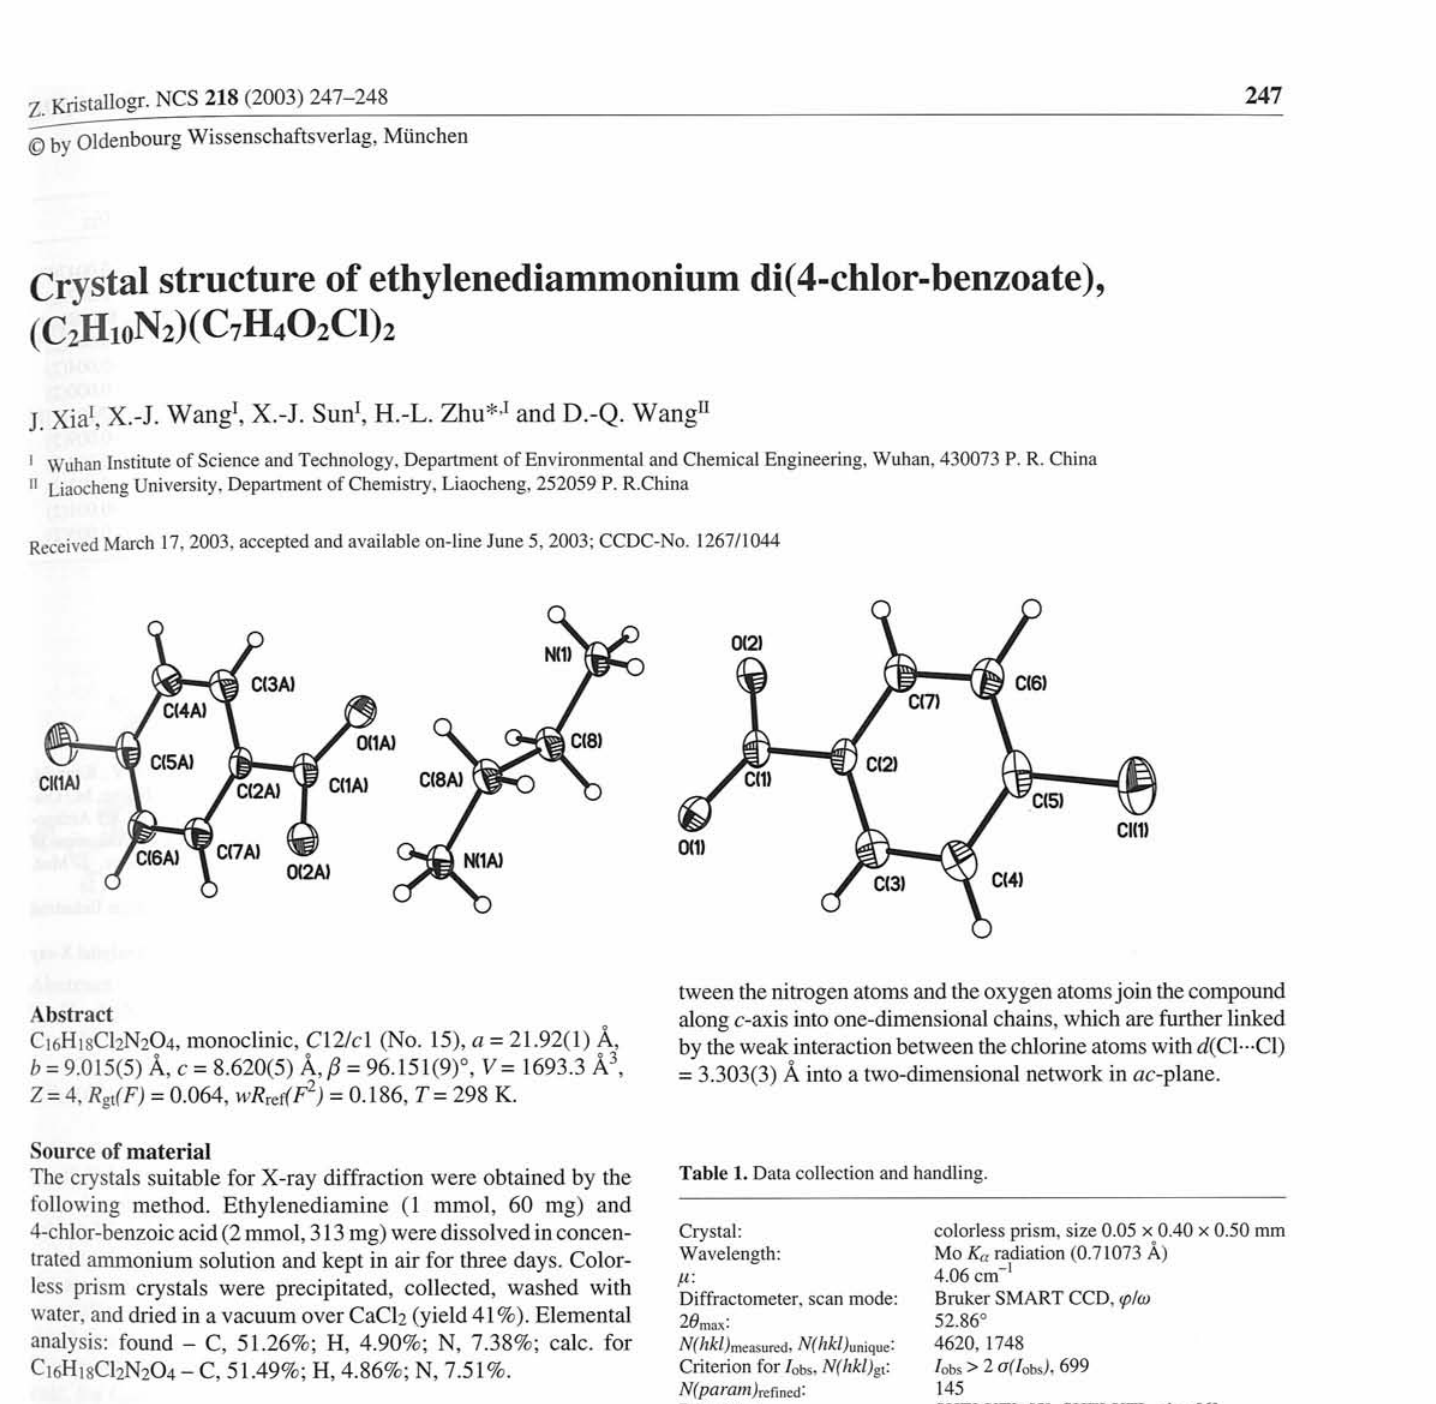
Table 2. Atomic coordinates and displacement parameters (in